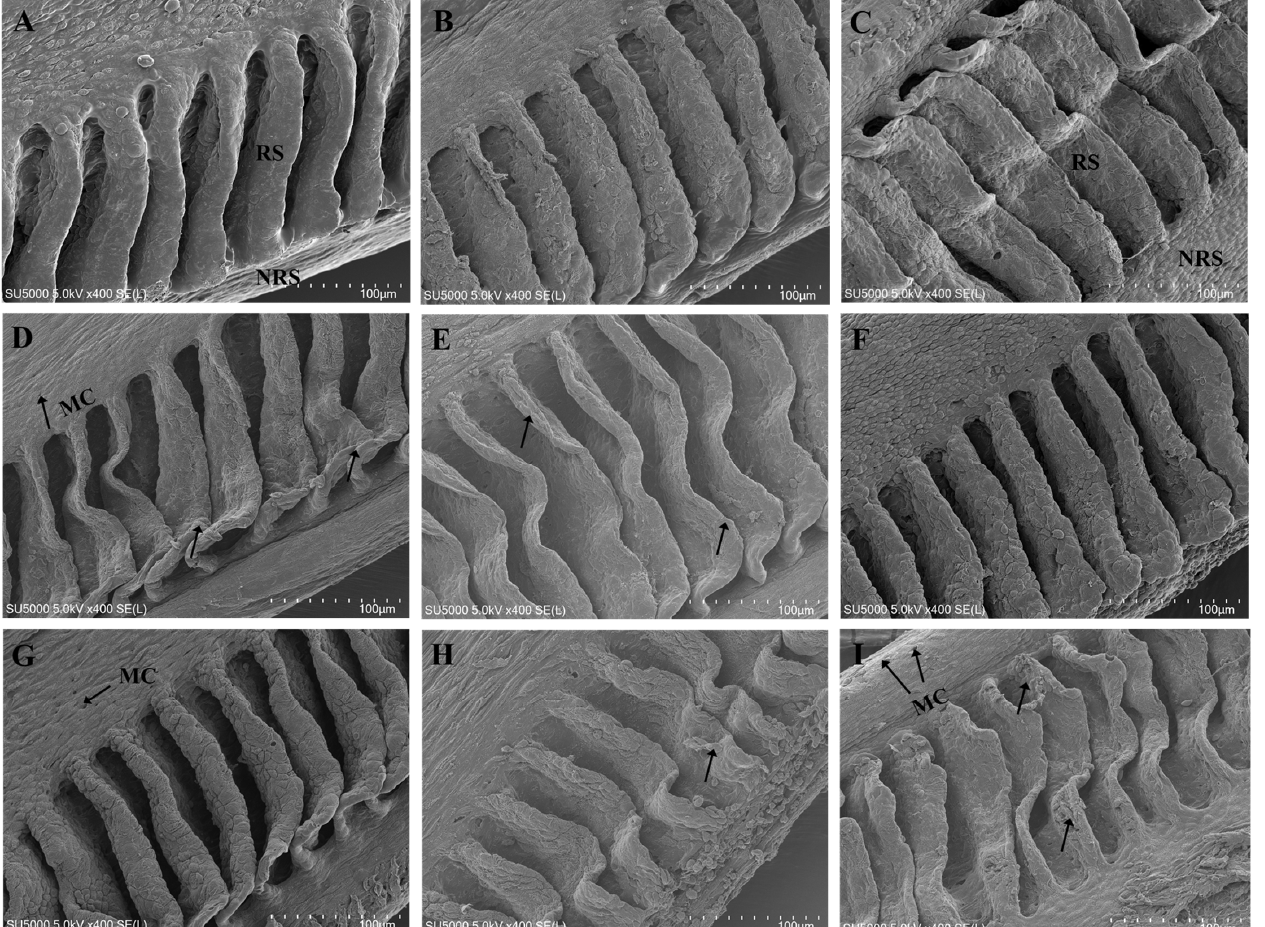
( B ) Figure 7. Quantification of fish gill structure. Lamellar surface area of gill ( A ) and interlaminar distance of gill ( B ) in grouper. Different lowercase letters indicate that there are significant differences among groups ( p < 0.05).